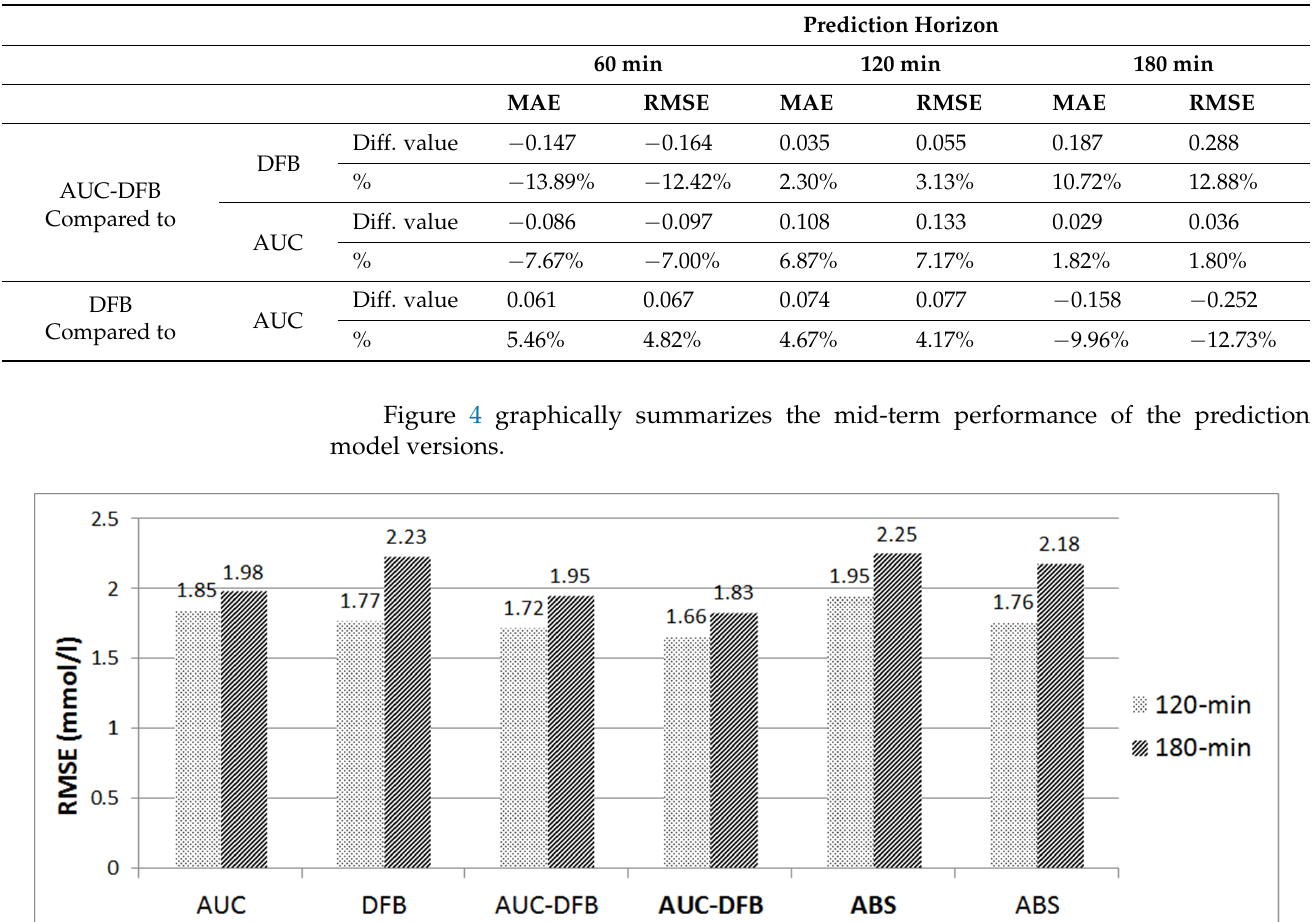
Figure 4. RMSE results on the 120 and 180 min PHs, comparison of the various prediction models. All values are in mmol/L.